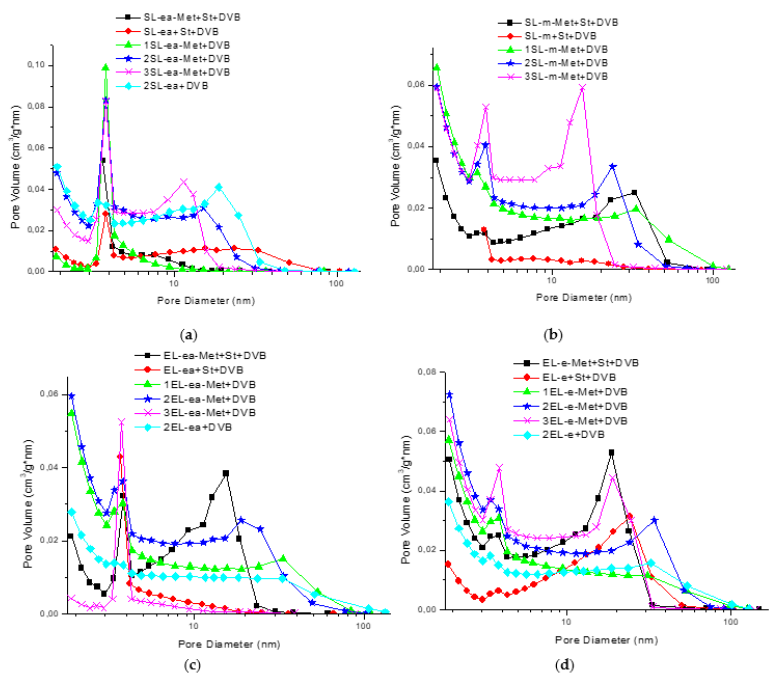
Figure 4. Pore size distribution curves of polymers containing ( a ) SL-ea, ( b ) SL-m, ( c ) EL-ea, and ( d ) EL-e. Table 5. Swelling